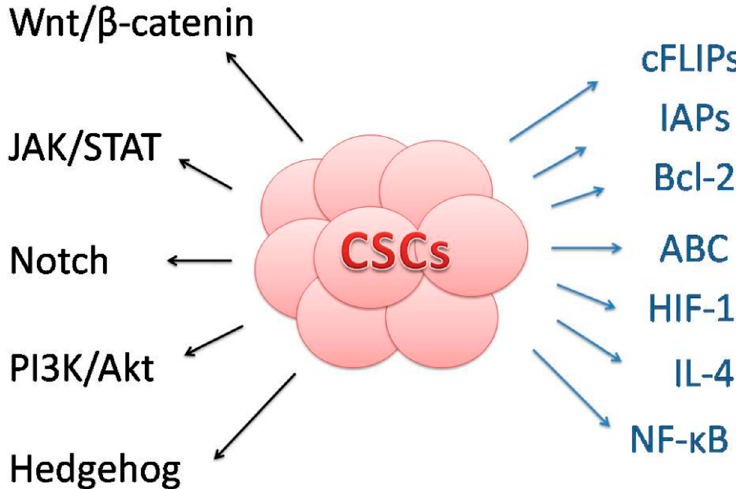
Figure 2. Mechanisms involved in stem-like maintenance and death resistance of CSCs.